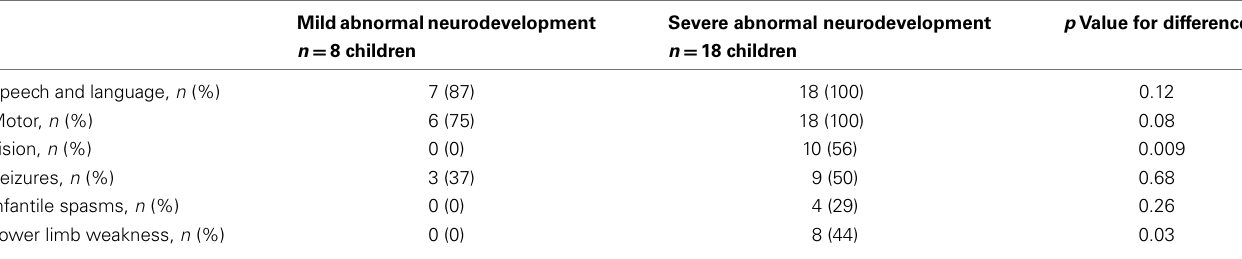
Table 2 | Mild and severe abnormal neurodevelopment characterized in the domains of speech and language, motor, vision, seizures, infantile spasms, and limb